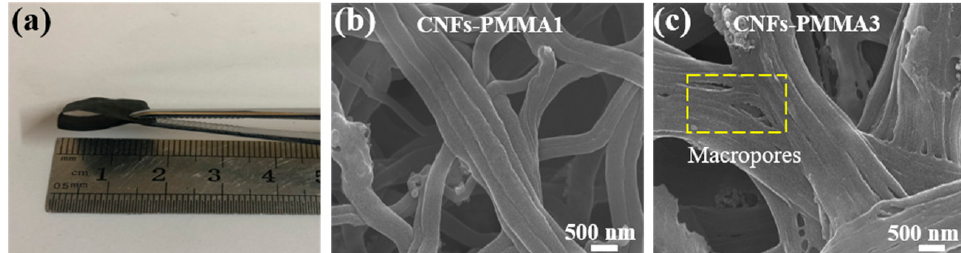
Figure 2. ( a ) A digital photo of the hierarchical porous and Si/N co-doped carbon nanofiber cloth, SEM images of ( b ) CNFs-PMMA1 and ( c ) CNFs-PMMA3. To obtain the optimal addition content of PMMA, the cycle and rate performances of CNFs-PMMA1, CNFs-PMMA2, CNFs-PMMA3, and CNFs-PMMA4 anodes in lithium- ion batteries are tested, and the results are used as the basis for selecting the content of PMMA. Figure 3a shows cycle performance curves of the four anodes at a current density of 0.05 C, from 0.01 to 3 V. The CNFs-PMMA3 anode has the highest initial capacity of 1437.2 mAh g − 1 among the four anodes. After 100 cycles, the CNFs-PMMA3 anode can still reach 985.3 mAh g − 1 . Figure 3b shows the rate performance curves of four anodes. Compared with CNFs-PMMA1, CNFs-PMMA2, and CNFs-PMMA4 anodes, the CNFs-PMMA3 anode shows excellent rate performance. The specific capacity of the CNFs- PMMA3 anode is 1469.9, 1307.6, 1213.1, 956.3 and 686.3 mAh g − 1 at the current density of 0.05, 0.1, 0.2, 0.5 and 1 C, respectively. Therefore, the amount of PMMA added in CNFs-PMMA3 is selected as the optimal